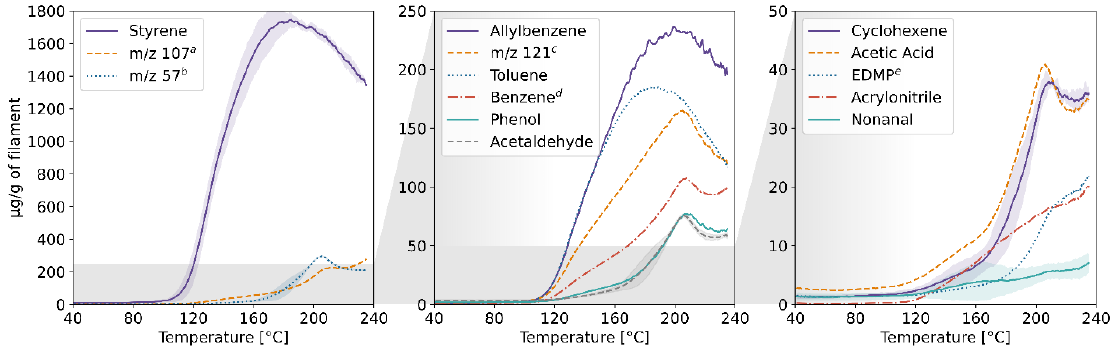
Figure 1. Temperature-dependent emission profile of the ABS filament. The grey horizontal field indicates the area magnified in the following sub-plot, and the coloured shaded areas indicate SD ( n = 3, only selected ones shown for clarity). A rolling average of n = 10 data points. a m/z 107: benzaldehyde, C 8 -alkylbenzenes; k = 2.24 × 10 −9 cm 3 s −1 ; b m/z 57: product of butanol fragmentation in the PTR-MS drift chamber; c m/z 121: acetophenone, C 9 -alkylbenzenes; k = 2.40 × 10 −9 cm 3 s −1 ; d likely a product of C 9 -alkylbenzenes fragmentation in the PTR-MS drift chamber; e 3-ethyl-2,5-dimethyl-pyrazine.